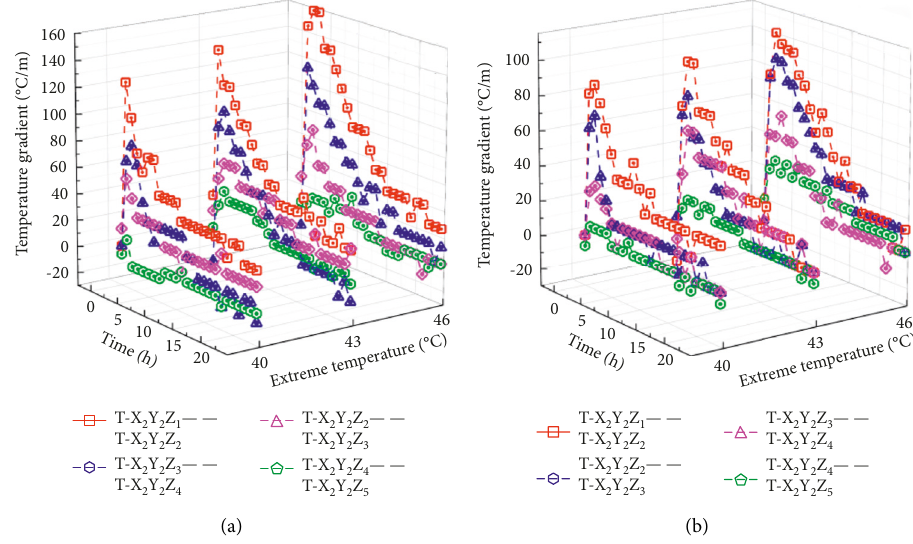
Figure 8: Temperature gradient time curve of the scaled specimen. (a) Vertical temperature gradient time curve of the constraint specimen and (b) vertical temperature gradient time curve of the freedom